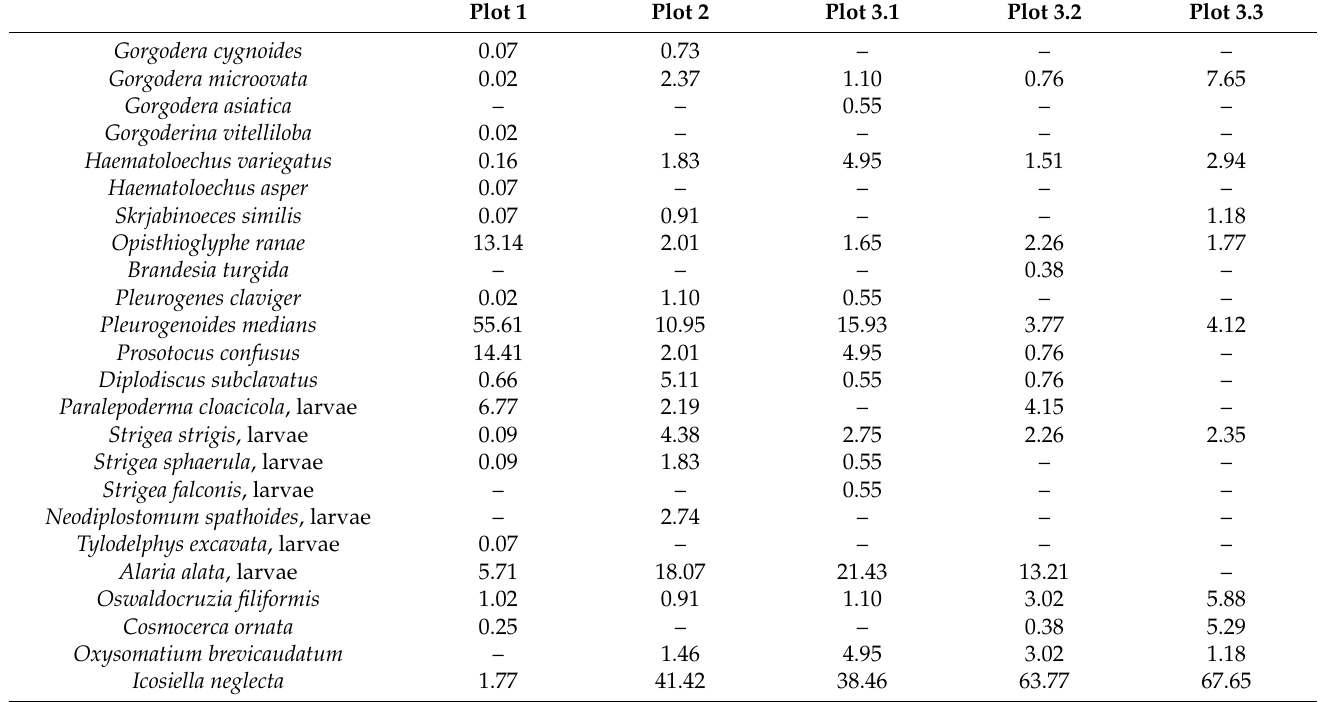
Table 3. Degree of dominance (%) in the helminth community structure. Plot 1 Plot 2 Plot 3.1 Plot 3.2 Plot